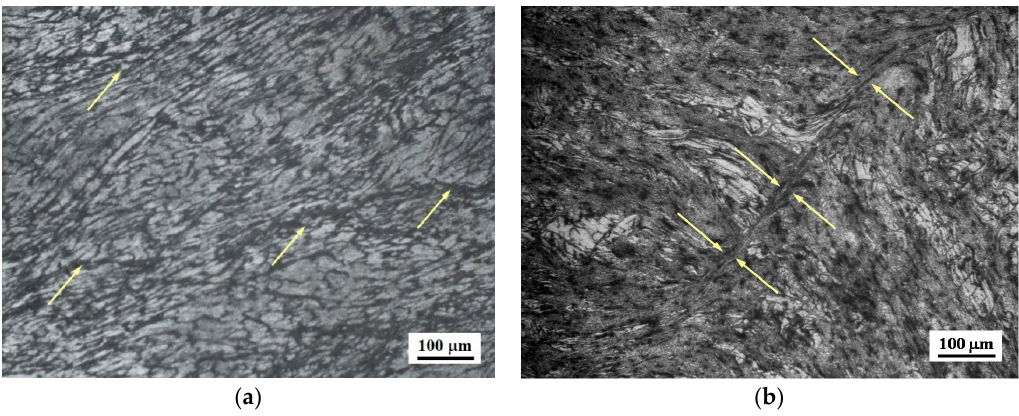
Figure 8. Deformed microstructures obtained in the instability regime of AZ31-2Ca alloy at ( a ) as-cast alloy at 300 °C/10 s − 1 , exhibiting flow localization; and ( b ) DMD processed at 300 °C/1 s − 1 , showing adiabatic shear band.